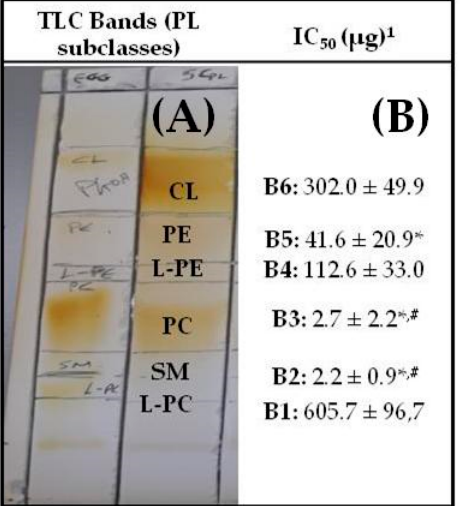
Figure 1. Thin layer chromatography (TLC) analysis of bioactive Irish ale polar lipid (PL) extracts into PL subclasses ( A ), along with the in vitro antithrombotic properties of TLC-derived bands of the PL subclasses against platelet-activating factor (PAF)-induced aggregation of human platelets ( B ). ( A ) For the TLC analysis, a standard mixture of egg phospholipids was co-assessed (left column of the TLC plate) with the Irish ale PLextract (right column of the TLC plate), and relevant bands—PL subclasses—were visualised by I2 vapours for both the standard and sample. ( B ) 1 Results are expressed as mean values ± SD of IC 50 measured as the mass of the ale PL subclass ( µ g) in the aggregometer cuvette that inhibited 50% of the PAF-induced platelet aggregation in human platelet-rich plasma (hPRP); * statistically significant di ff erences ( p < 0.05) of the bioactivities of ale PL subclasses of TLC bands 2 (sphingomyelin (SM)), 3 (phosphatidylcholines (PC)) and 5 (phosphatidylethanolamines (PE)) when compared to the other bands 1 (lyso-PC (L-PC)), 4 (lyso-PE (L-PE)) and 6 (egg cardiolipin (CL)). # Statistically significant di ff erences ( p < 0.05) of the bioactivities of ale PL subclasses of TLC bands 2 (SM) and 3 (PC) when compared to the band 5 (PE). The results are representative of independent experiments in blood samples of di ff erent healthy donors (n = 6) in order to ensure reproducibility. SD: standard deviation; PC: Phosphatidylcholines; PE: Phosphatidylethanolamines; SM: molecules